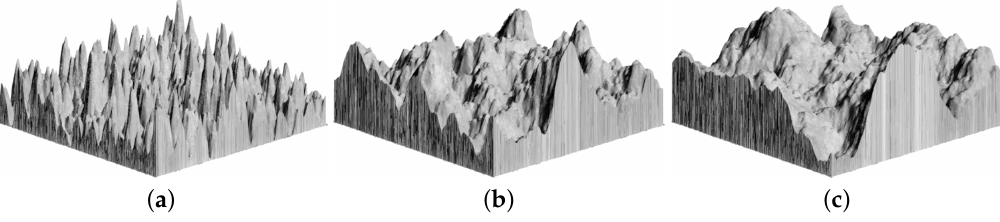
Figure 15. Comparison of the impact of the fault radius on the model geometry (grid resolution: 100 × 100; fault height (max in centre): 0 (cid:54) ∆ h (cid:54) 1). ( a ) r = 3. ( b ) r = 10. ( c ) r =